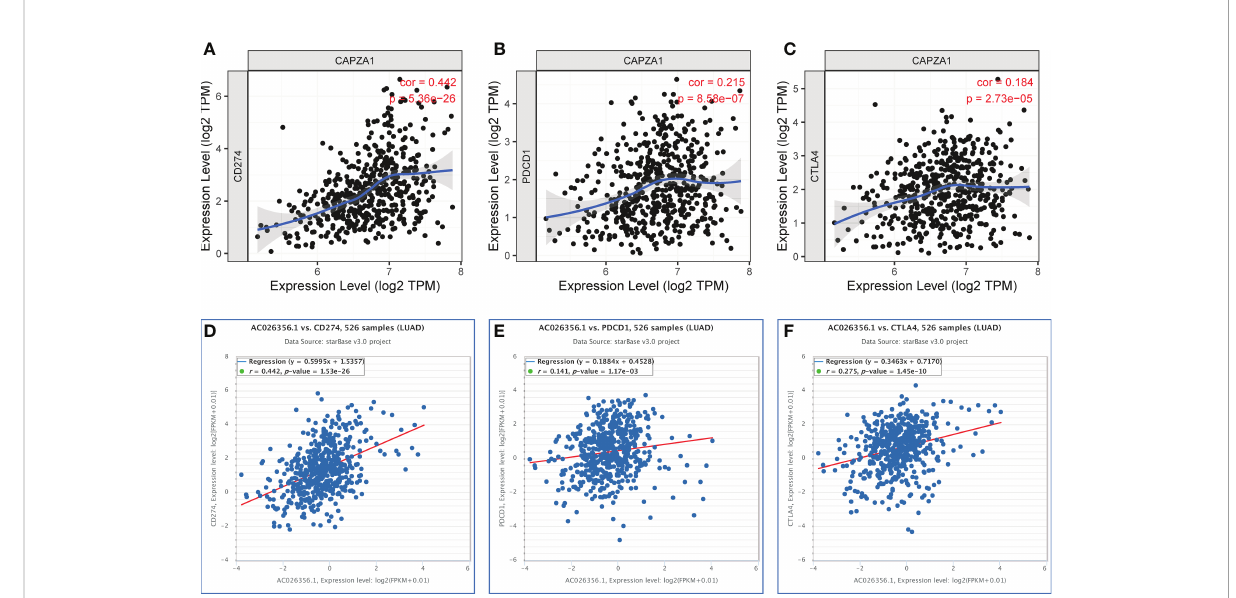
FIGURE 8 Correlation of CAPZA1 and AC026356.1 expression with PD-1, PD-L1, and CTLA-4 expression in LUAD. (A) Spearman correlation of CAPZA1 with expression of PD-L1 in LUAD using TIMER. (B) Spearman correlation of CAPZA1 with expression of PD-1 in LUAD using TIMER. (C) Spearman correlation of CAPZA1 with expression of CTLA-4 in LUAD using TIMER. (D) The expression correlation of AC026356.1 with PD-L1 in LUAD was determined by the starBase database. (E) The expression correlation of AC026356.1 with PD-1 in LUAD determined by the starBase database. (F) The expression correlation of AC026356.1 with CTLA-4 in LUAD was determined by the starBase database.